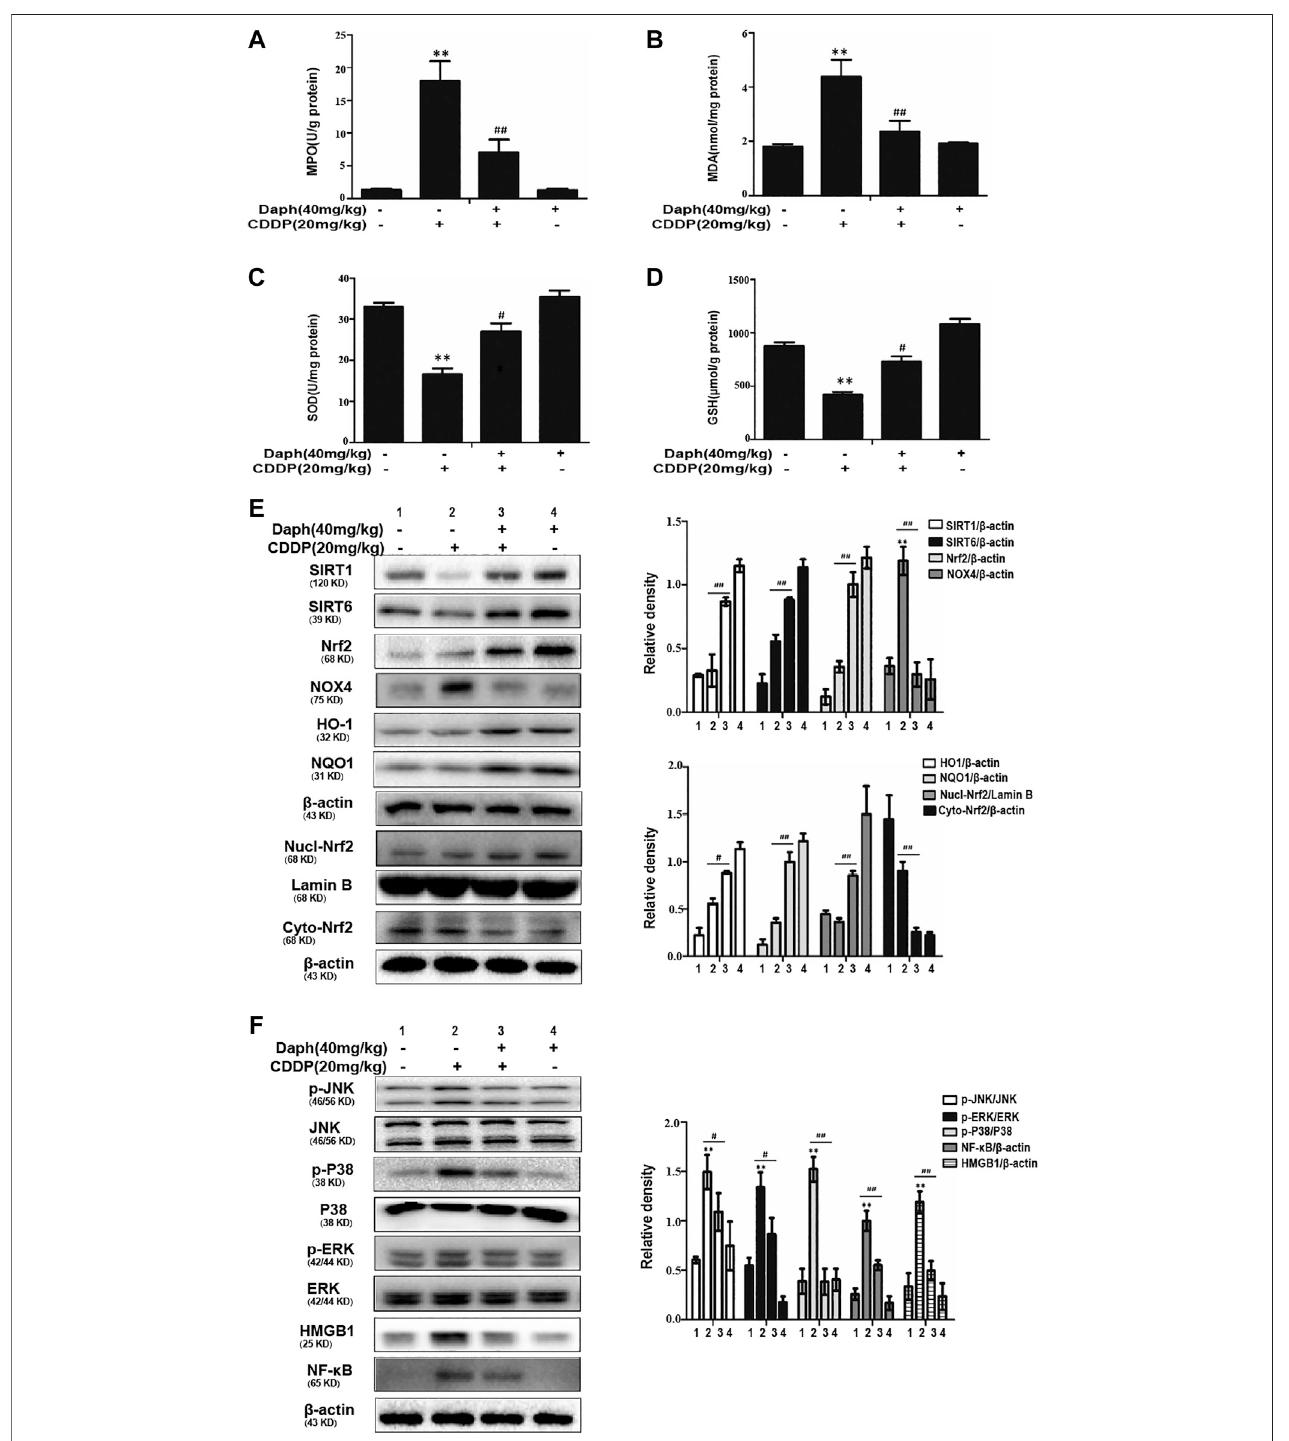
FIGURE3| Daphinhibitsoxidativestressandin fl ammationinWTmice. (A – D) MPO,MDA,SODandGSHlevelsinAKImice. (E) Westernblotsanalysisshowingthe expression levels of SIRT1, SIRT6, total Nrf2, nuclear Nrf2, cytoplasmic Nrf2, HO-1, NQO1 and NOX4 in the kidneys from WT mice. (F) Western blots analysis showing the expression levels of p-JNK, JNK, p-p38, p38, (p)-ERK1/2, ERK1/2, HMGB1 and NF- κ B in the kidneys from WT mice. Data are presented as the mean ± SEM, n (cid:2) 5 for all test groups. * p < 0.05 and ** p < 0.01 vs. the control group; # p < 0.05 and ## p < 0.01 vs. the CDDP group.